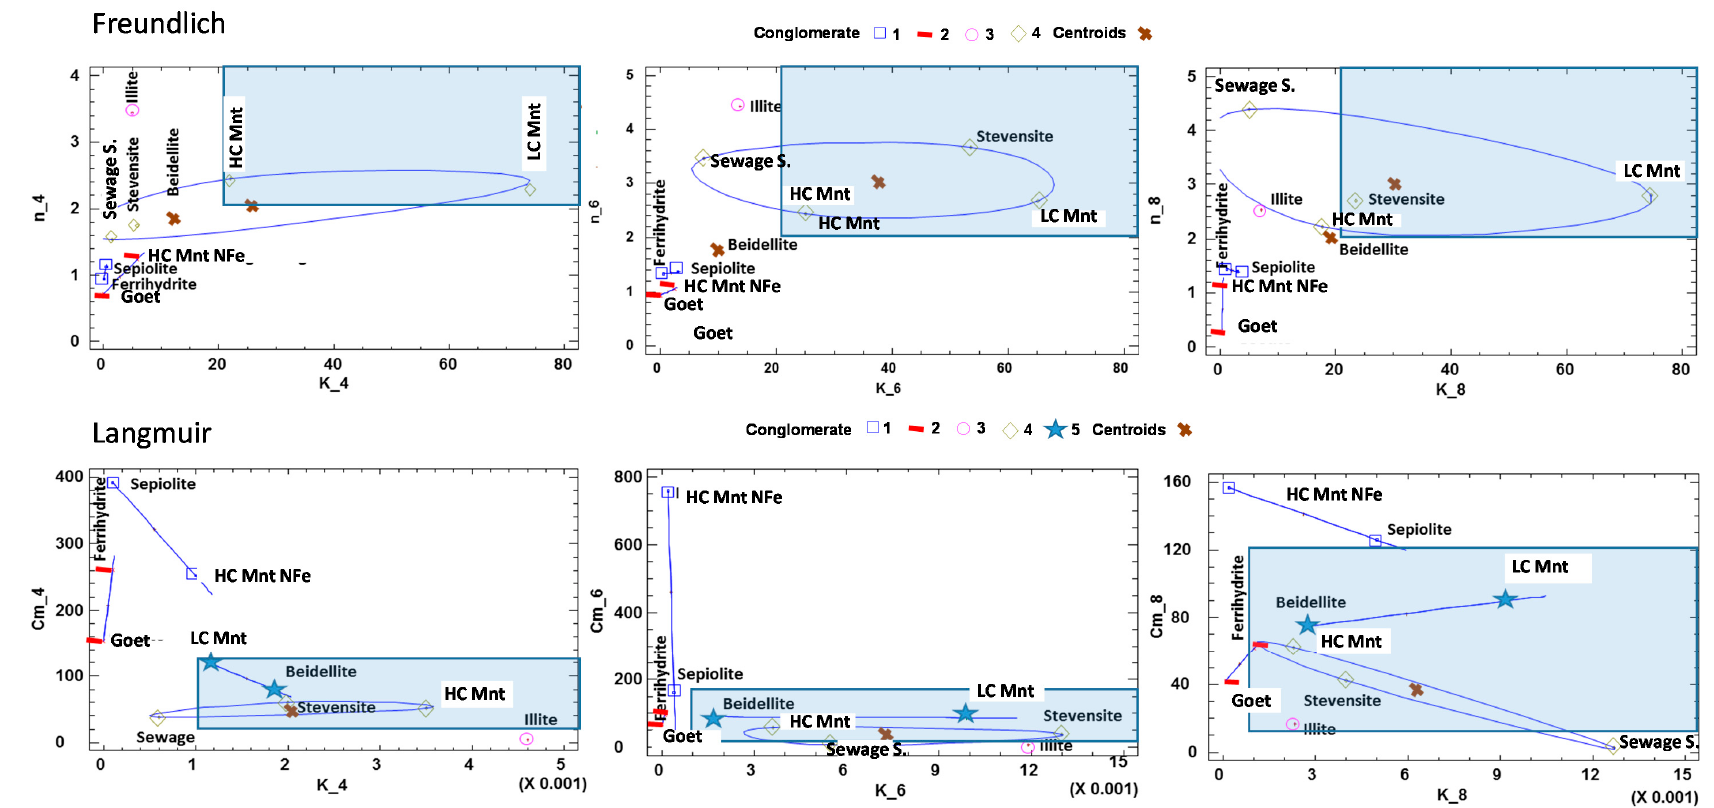
Figure 10. Material classification according to the statistical analysis of Freundlich and Langmuir isotherm parameters (K and n) as a function of pH interaction. Conglomerates dispersion diagram determined by the Euclidean quadratic K-average method implemented in STATGRAPHICS ® v.16.1 software. (n_4, n_6, n_8 = n value for each pH; Cm_4, Cm_6, Cm_8 = Cm; K_4, K_6, K_8 = K value for each pH value). Shaded areas mark the optimum values defined for adsorption intensity and capacity for the fitted parameters (see text and Table 4).